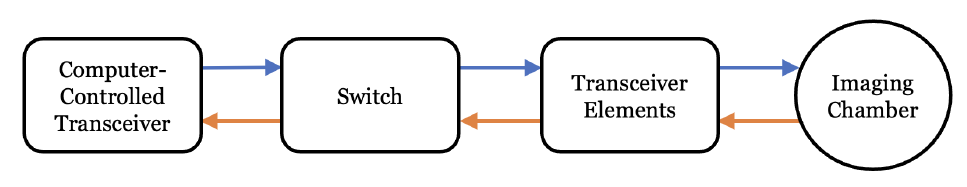
Figure 2. Flowchart of MWI and USI system components. For USI, the computer-controlled transceiver (CCT) consists of a PC, AWG, and digital oscilloscope; the transceiver elements are US transducers. For MWI, the CCT is a VNA and the transceiver elements are magnetic field